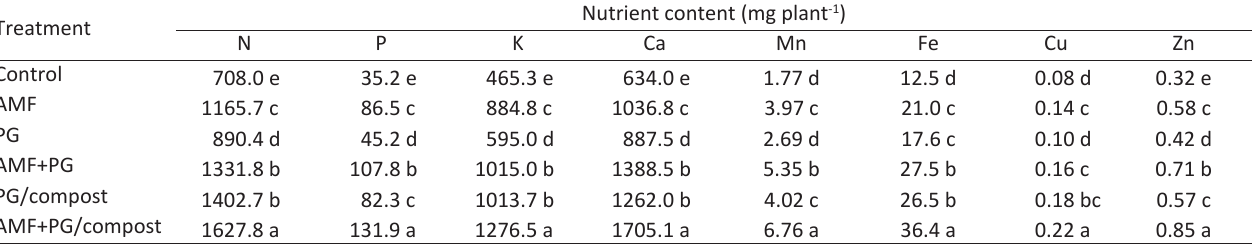
Table 4 - Contents of nutrients in cotton plants grown with different treatments of arbuscular mycorrhizal fungi (AMF) and added phos- phogypsum (PG) Treatment